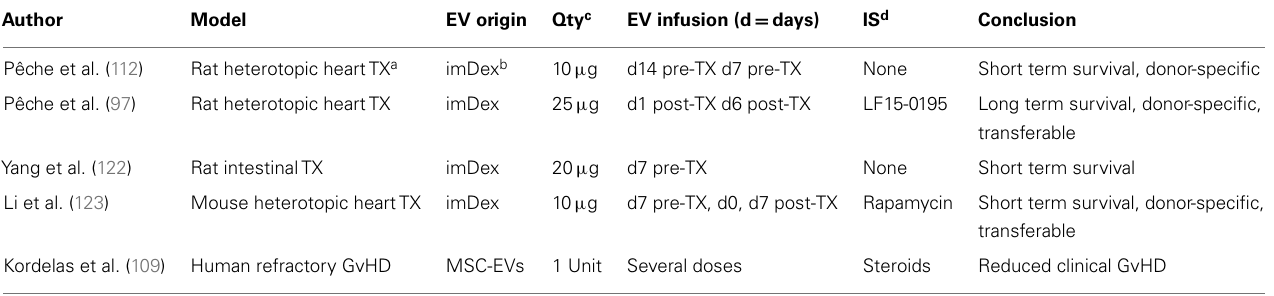
Table 1 | EV treatments in transplantation-related settings